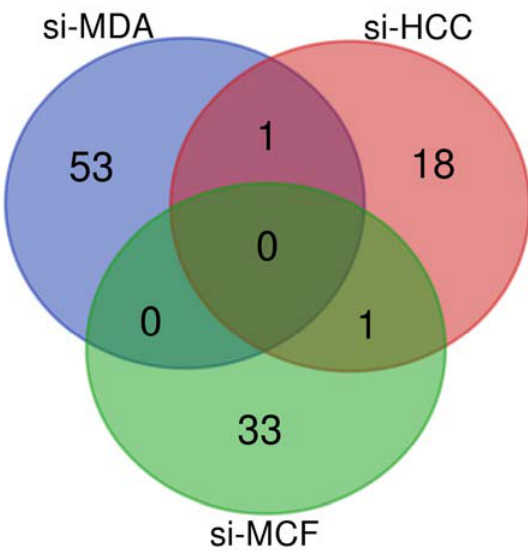
Figure 2. Venn diagram based on the lists of altered genes related to redox metabolism found in breast cancer models silenced for NF- κ B/p65 compared with their scramble counterparts. Si-MDA: NF- κ B/p65-silenced MDA-MB-231; si-HCC: NF- κ B/p65-silenced HCC-1954; and